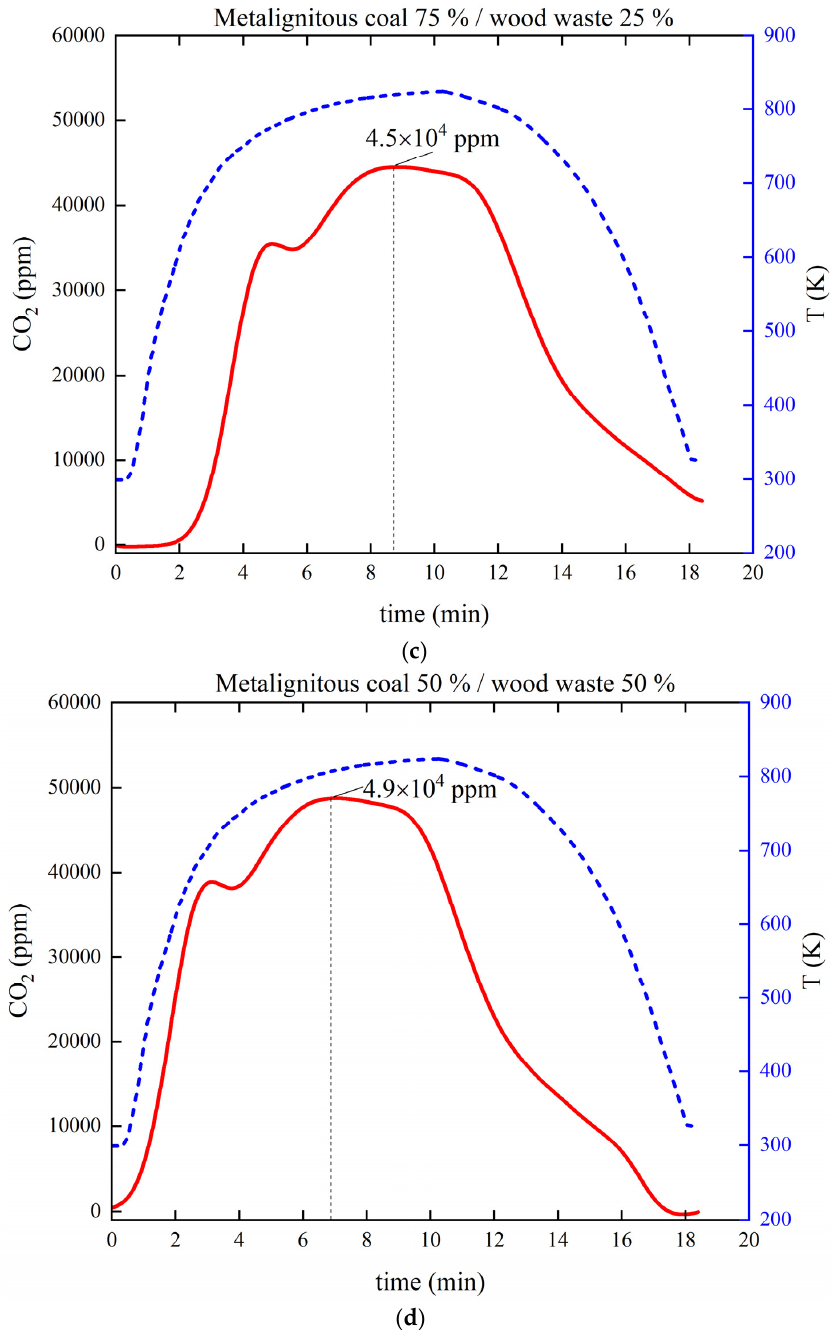
Figure 4. Changes in the concentration of carbon dioxide in the gaseous products of thermal decom- position of mixed fuels based on D-grade coal and wood with a change in the proportion of the latter in the mixture from 10% to 50%: ( a ) metalignitous coal 100%; ( b ) metalignitous coal 90%/wood waste 10%; ( c ) metalignitous coal 75%/wood waste 25%; ( d ) metalignitous coal 50%/wood waste 50%.